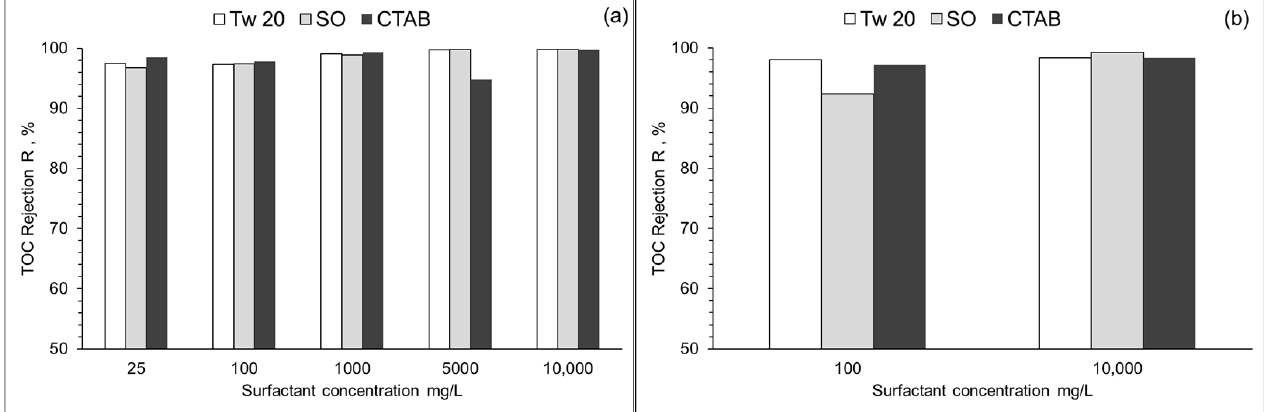
Figure 9. TOC rejection ( R ) of PA ( a ) and CA ( b ) membrane at different surfactant concentrations. (10% recovery ratio, TMP = 1.5 MPa, T = 25 °C)